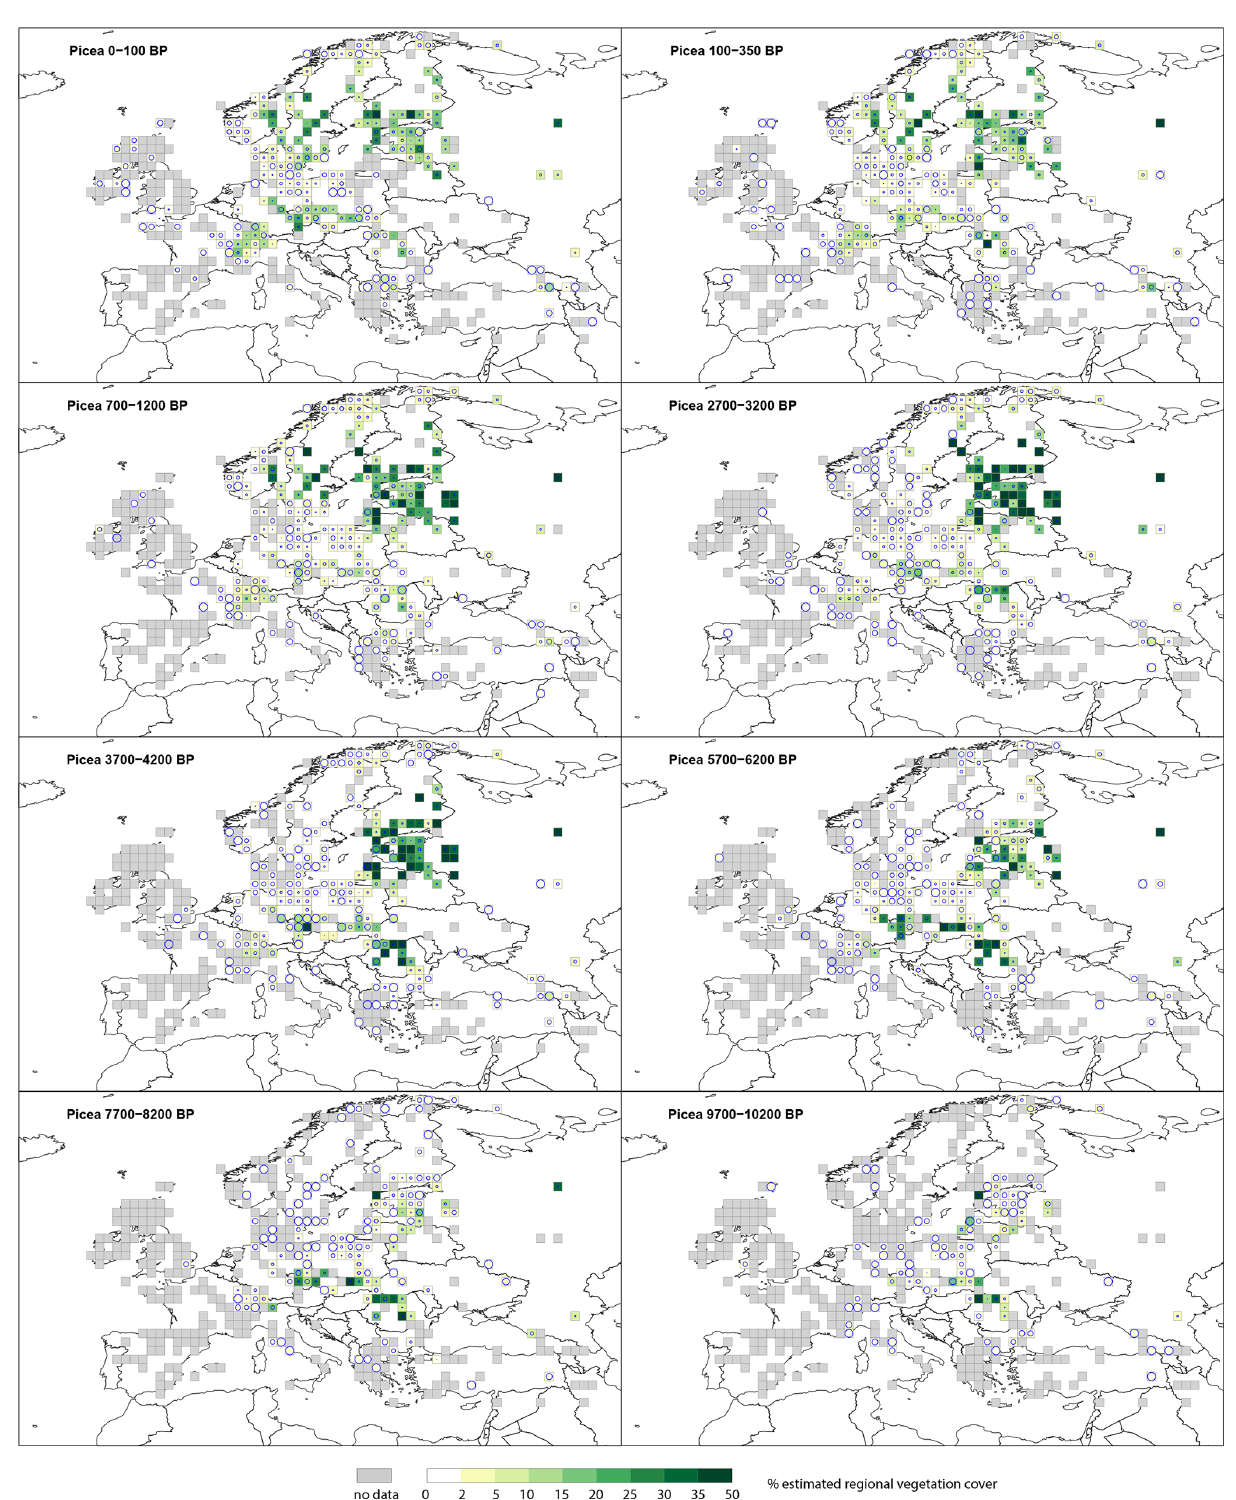
Figure 6. Grid-based REVEALS estimates of Picea cover for eight Holocene time windows. Percentage cover in 1% intervals between 0% and 2%, 3% intervals between 2% and 5%, 5% intervals between 5% and 30%, and 20% intervals between 30% and 50%. Intervals represented by increasingly darker shades of green from 5%–10%. Grey cells: cells without pollen data for the time window but with pollen data in other time windows. Circles in grid cells represent the coefficient of variation (CV; the standard error divided by the REVEALS estimate). When SE ≥ REVEALS estimate, the circle fills the entire grid cell, and the REVEALS estimate is not different from zero. This occurs mainly where REVEALS estimates are